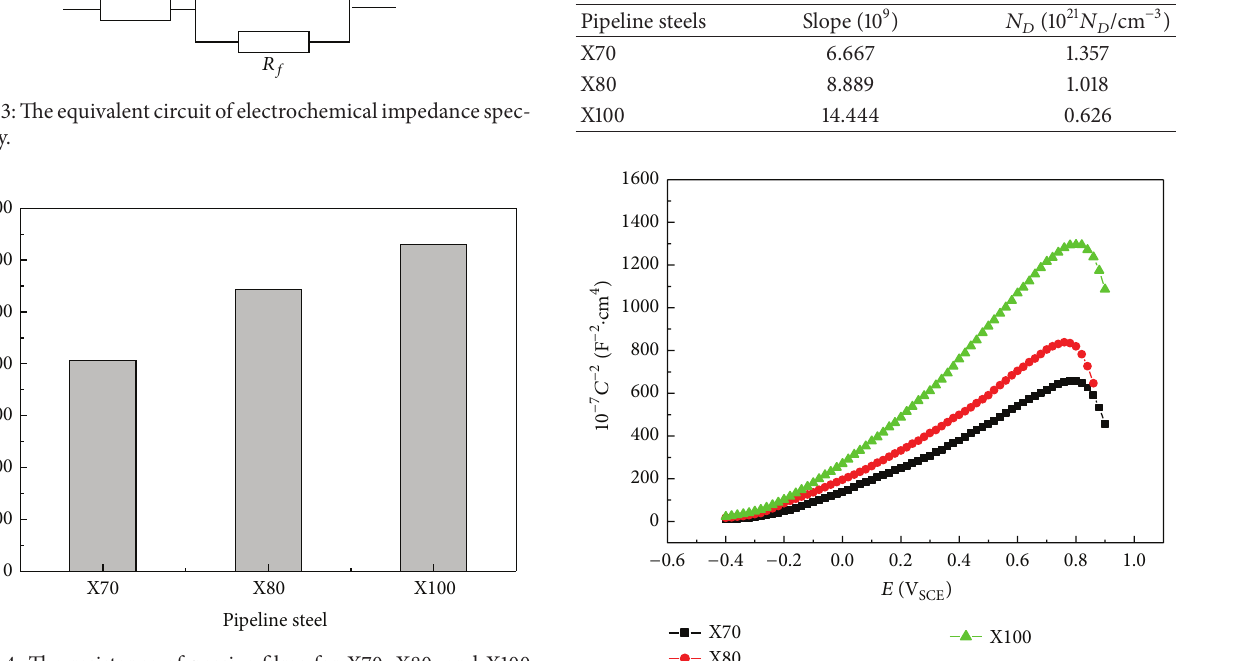
Figure 4: The resistance of passive films for X70, X80, and X100 pipeline steels in 3.5 wt.% NaCl solution.